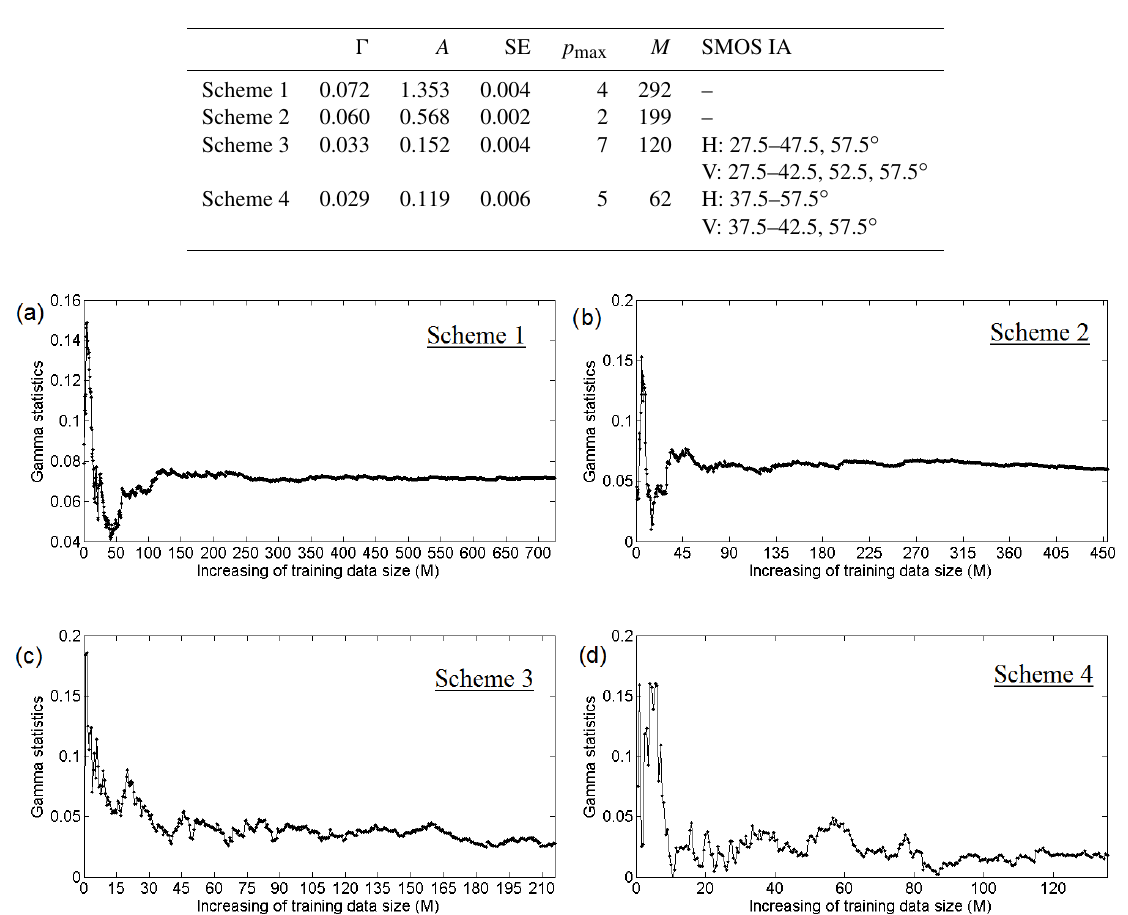
Figure 4. M -test to find the best training data size: (a) scheme 1, (b) scheme 2, (c) scheme 3, and (d) scheme